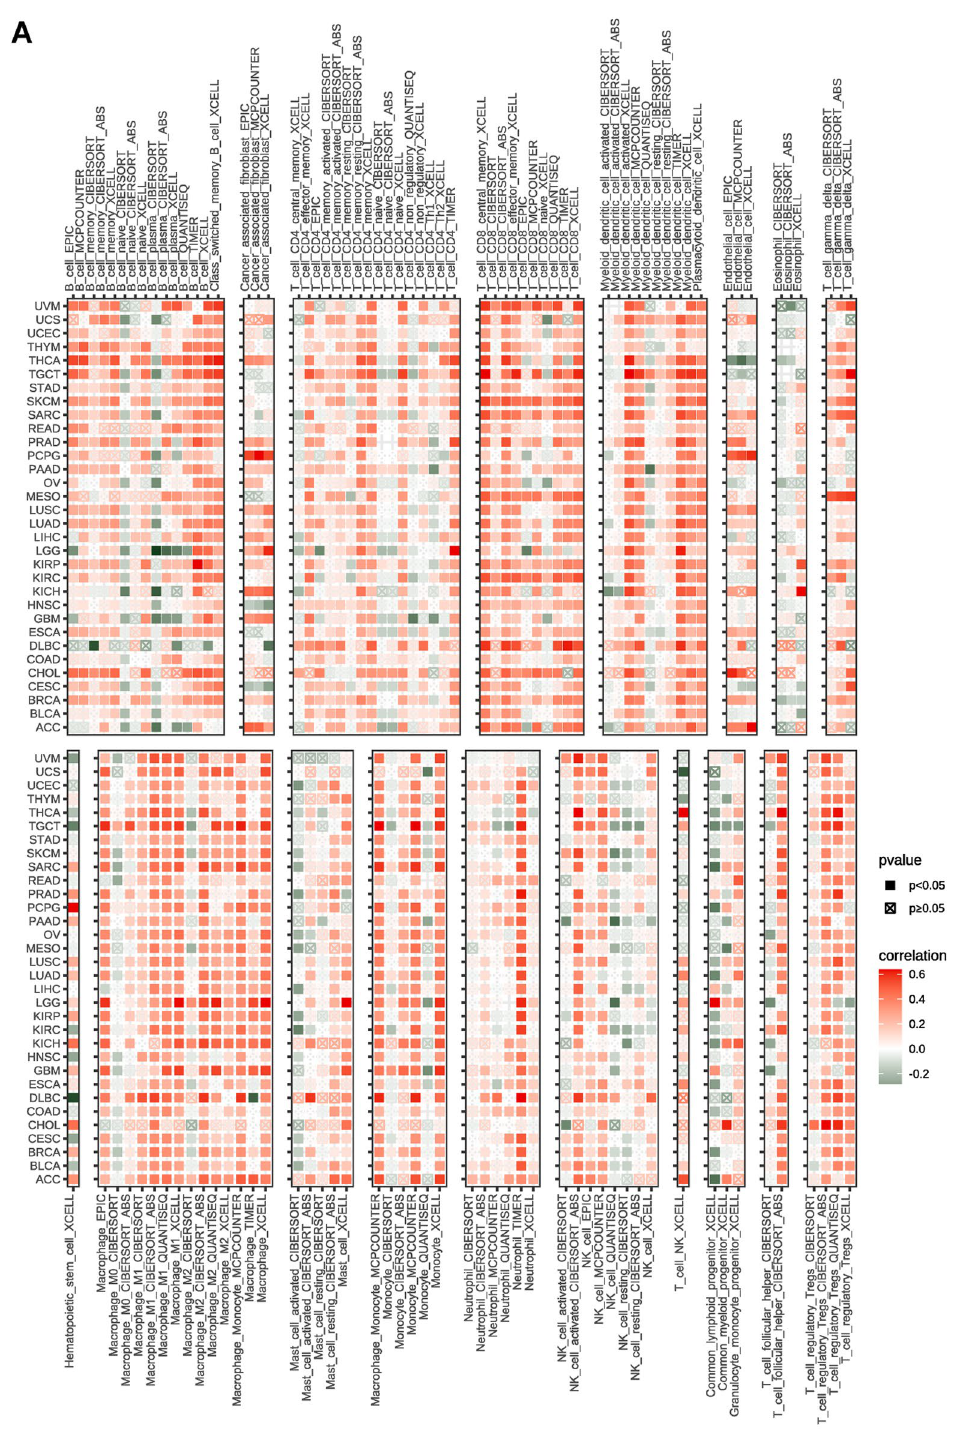
Figure 10. Relationship of PANoptosis score with immune cell infiltration analysis. ( A ) The analysis of immune cell infiltration based on TIMER2 database. ( B ) The analysis of immune cell infiltration based on ImmuCellAI